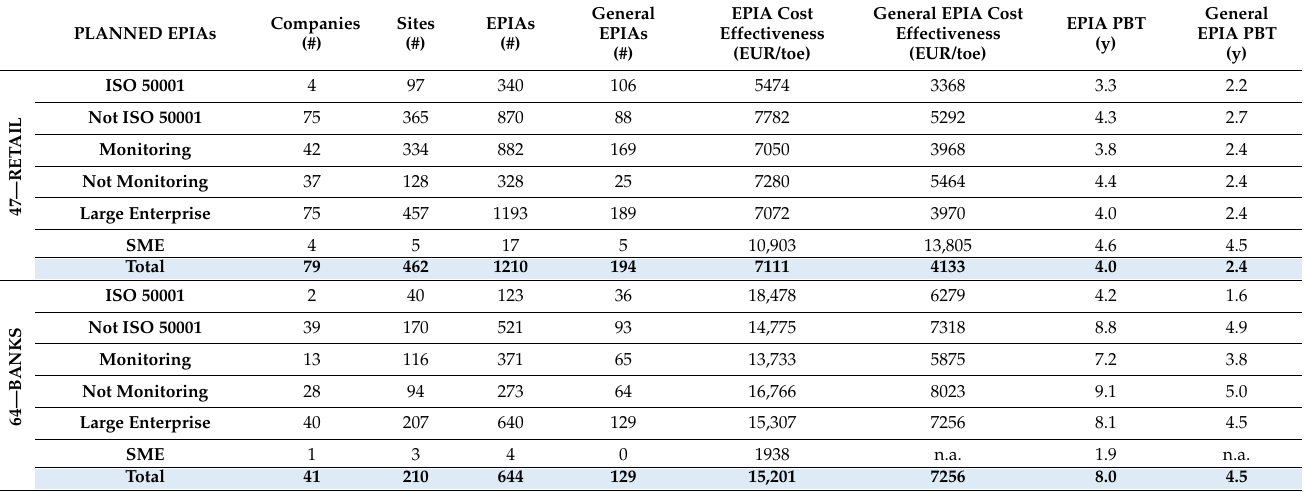
Table 4. Retail and bank sector planned EPIAs.